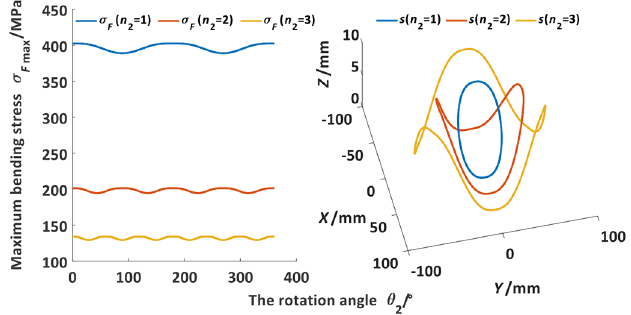
Fig. 11. Tooth root bending stress of x =2 mm.